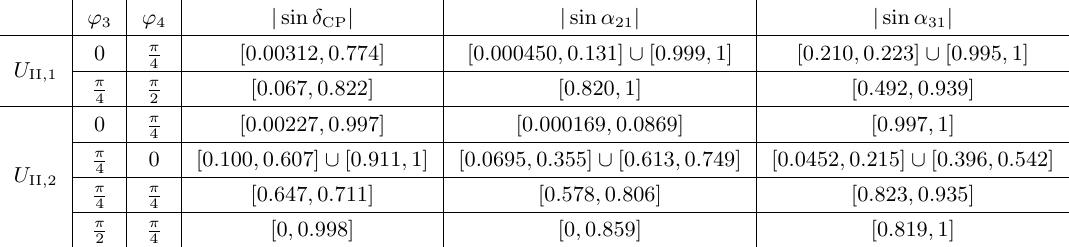
Table 6 . The allowed regions of j sin (cid:14) CP j , sin (cid:11) 21 and j sin (cid:11) 31 j for the viable mixing patterns of case II with n = 4, where both free parameters (cid:18) l and (cid:18) (cid:23) freely vary in the fundamental region [0 ; (cid:25) ] and all the three lepton mixing angles are required to lie within their 3 (cid:27) intervals [8].